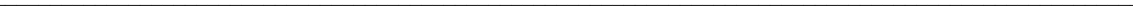
Fig. 6. Chitinozoan biozonal species in the Ludlow and P ř (cid:237)dol(cid:237) of the East Baltic drill cores. Scale 50 (cid:181)m. A , Conochitina postarmillata Nestor, GIT 527-40, Ventspils D-3 core, depth 647.0 m, Paadla Stage. B , Ancyrochitina desmea Eisenack, GIT 527- 42, Ventspils D-3 core, depth 613.0 m, Paadla Stage. C , Angochitina elongata Eisenack, GIT 189-28, Kaugatuma core,